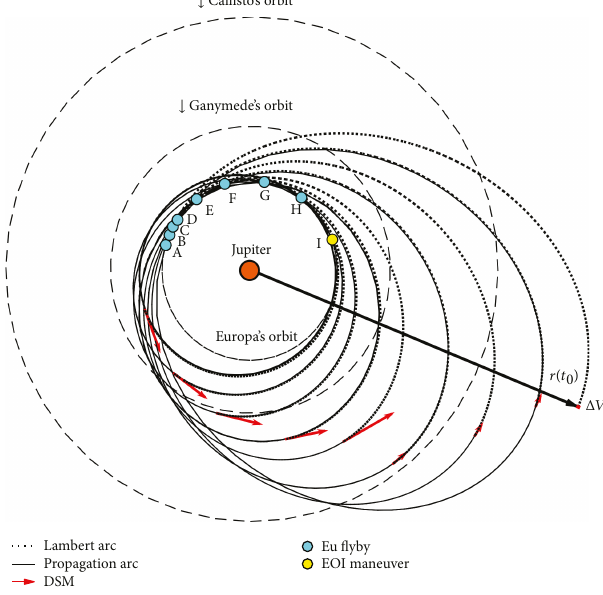
Figure 8: Jovicentric trajectory of solution